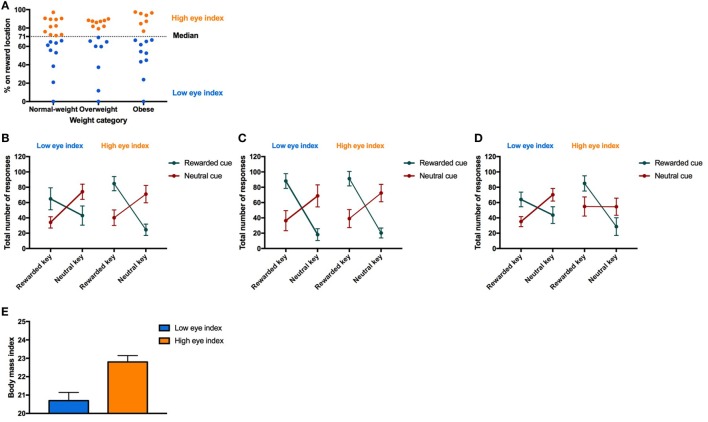
Result from Pavlovian-to-instrumental transfer (PIT) for the “low eye index” and “high eye index” group. Error bars indicate SEM. The rewarded key/condition is depicted in green and the neutral key/condition in red. The “low eye index” group is represented in blue and the “high eye index” group in orange. (A) Categorization of fixation style. Fixation style was based on a median split on the conditioned eye response in the second half of all trials after the rewarded cue during Pavlovian conditioning. (B–D) PIT effect for different weight categories and fixation styles. Fixation style showed a significant influence on PIT depending on the weight category (pCONDITION*RESPONSE TYPE*WEIGHT CATEGORY*FIXATION STYLE < 0.025). In the normal-weight group, the “low eye index” group consisted of 11 and the “high eye index” of nine individuals. In the overweight group, the “low eye index” group consisted of eight and the “high eye index” of nine individuals. In the obese group, the “low eye index” group consisted of 10 and the “high eye index” of 7 individuals. (E) Body mass index (BMI) in normal-weight individuals for each fixation style. The “high eye index” group showed an increased BMI within the healthy range compared to the “low eye index” group (p < 0.001, d = 1.7).